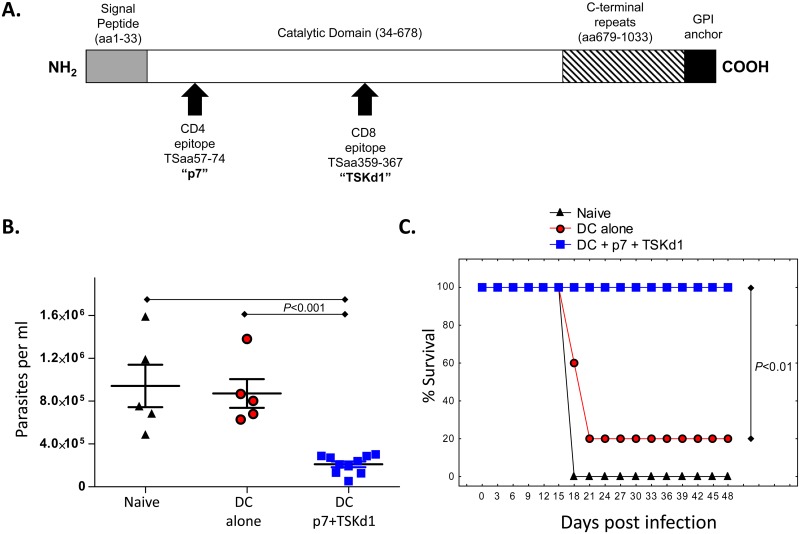
CD4+ TSaa57-74 (p7)/IAd- and CD8+ TSaa359-367 (TSKd1)/Kd-specific T cell responses are minimally sufficient for induction of protective T. cruzi immunity.Panel A shows a schematic of the TS consensus protein (all 12–15 active TS subfamily members have at least 90% homology within their catalytic domains), and immunodominant TS CD4 and CD8 epitopes. In panels B and C, BALB/c mice were vaccinated with dendritic cells (DC) pulsed (or not) with this pair of CD4 and CD8 epitopes and later challenged with T. cruzi. BALB/c CD11c+ splenic DC were purified from BALB/c mice 2 weeks after injection of 5x106 B16-Flt3L-producing cells and 1 day after i.v. injection of 1μg LPS. 1x106 DC pulsed (or left unpulsed) with 50 μg/ml of the indicated peptides were injected i.v. into groups of naïve BALB/c mice 3 times, 2 weeks apart. Mice were challenged 1 month later with T. cruzi (N = 5 in each of the two control groups and N = 10 in DC+TS peptide group). Both parasitemia (B; 2 weeks post-infection) and mortality (C) were significantly reduced in mice given DC pulsed with both TSaa57-74 (p7) and TSaa359-367 (TSKd1) [*p<0.001 by Mann-Whitney U test (B) and *p<0.01 by 2-tailed Fisher exact and Log-Rank [Mantel-Cox] tests(C)]. Survival results are representative of 3 independent experiments.